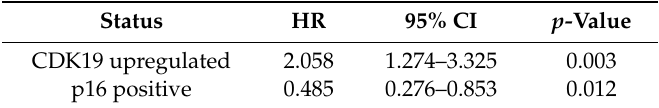
Figure 3. CDK19 upregulation correlates with better DFS. Kaplan–Meier diagrams showing ( a ) OS and ( b ) DFS. Table 1. Hazard ratio (HR), 95% confidence interval (CI)l, p -value of CDK19, and p16 status in multivariate Cox